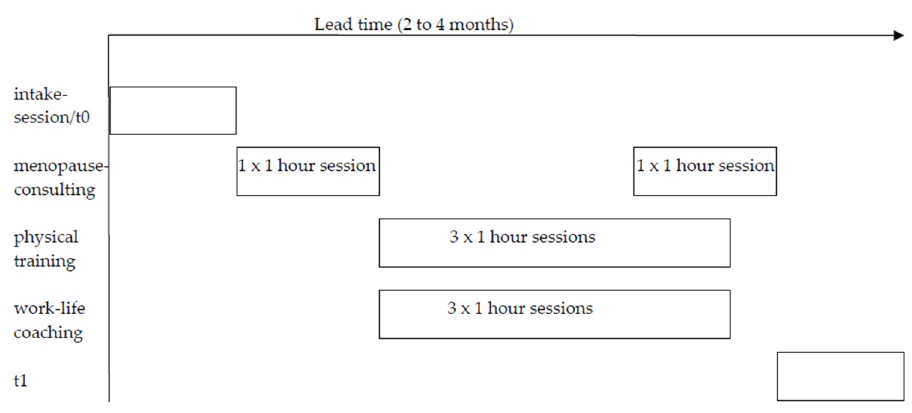
Figure 1. Work–life program.